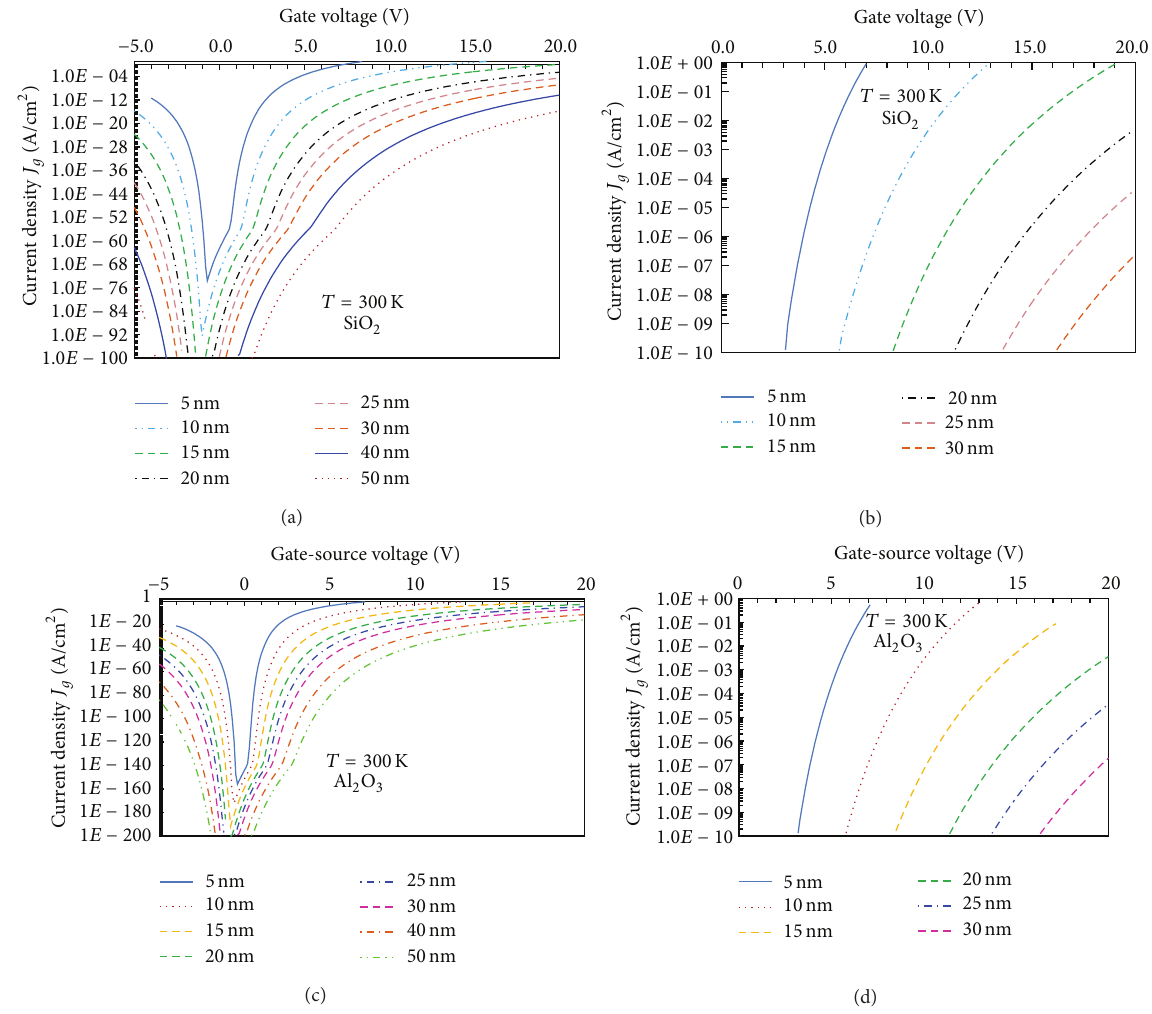
Figure 5: Gate current density at 300 K for different gate dielectric thicknesses using SiO 2 as a gate dielectric ((a), (b)) and Al 2 O 3 as a gate dielectric ((c), (d)). Zoomed-in view is also shown for SiO 2 (b) and Al 2 O 3 (d) at higher gate current